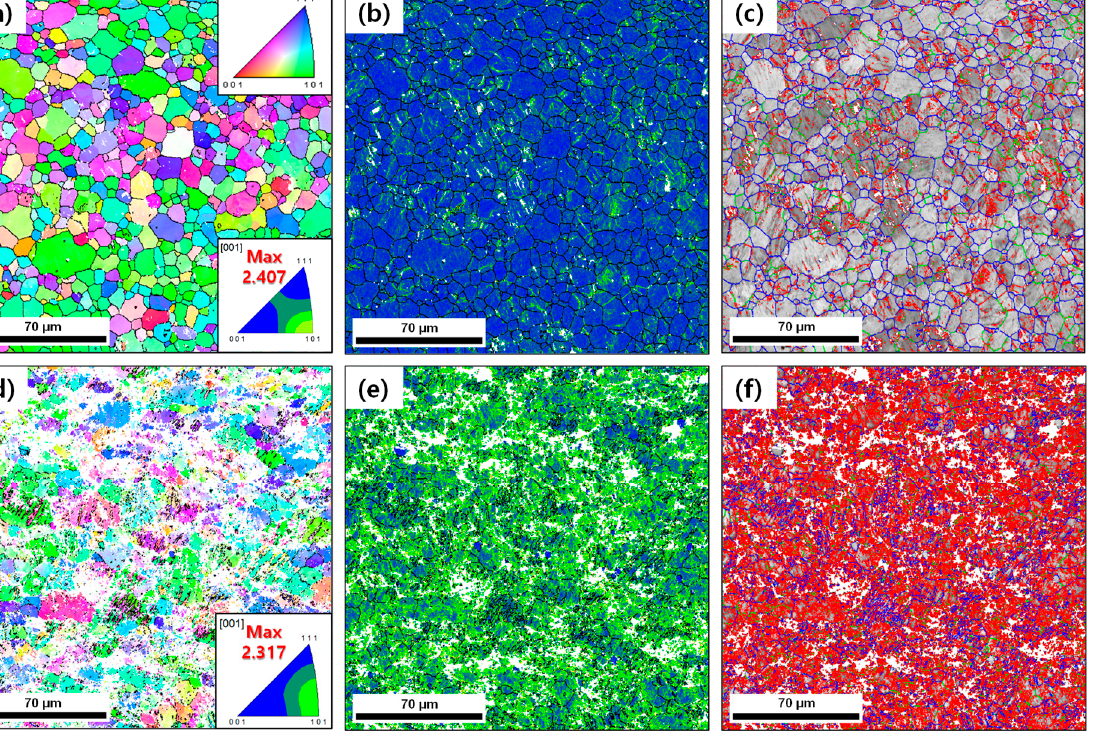
Figure 1. The inverse pole figure, KAM and GB maps for the ( a – c ) as-received (AR) and ( d – f ) HRDSR samples. In the GB map, low-angle boundaries (2–5°) are in red, intermediate angle boundaries (5–15°) are in green and high-angle boundaries (>15°) are in blue.